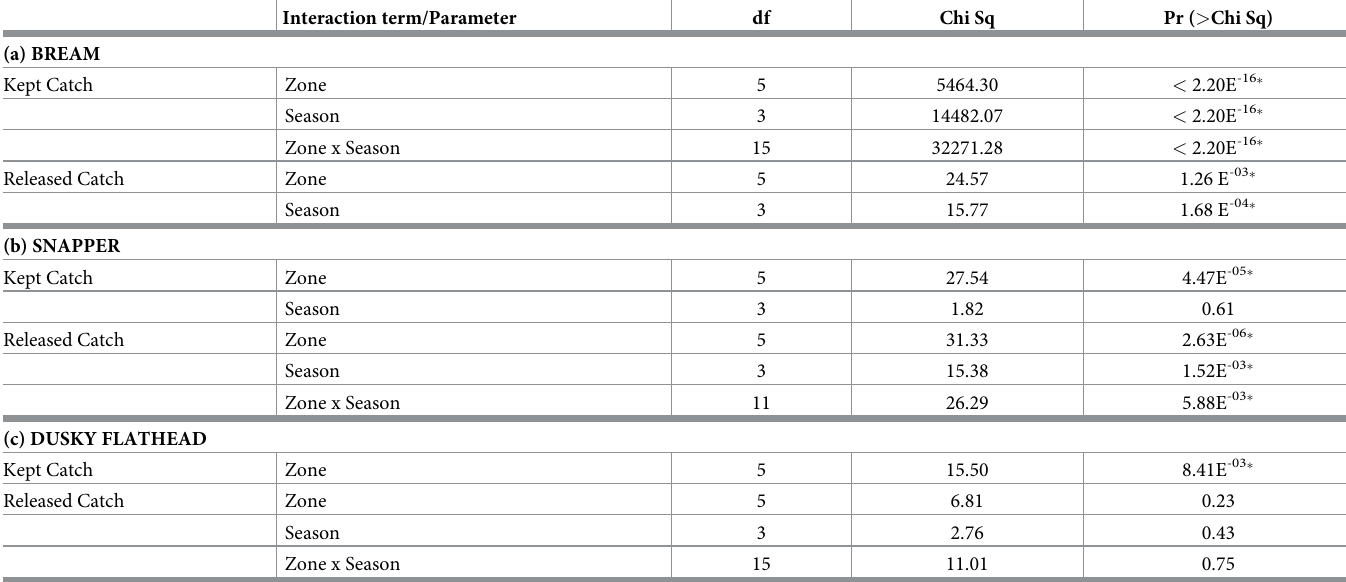
Table 2. Analysis of deviance tables showing the results of the generalized linear mixed effects models used to examine the influence of the categorical variables zone (6 levels: North Coast, Mid-North Coast, Hunter, Sydney, Mid-South Coast and South Coast) and/or season (4 levels: Autumn, Spring, Summer, Winter) on the number of estuary-caught (a) bream, (b) snapper and (c) dusky flathead that were kept and released from recreational fishing activity in NSW waters during 2013/14.